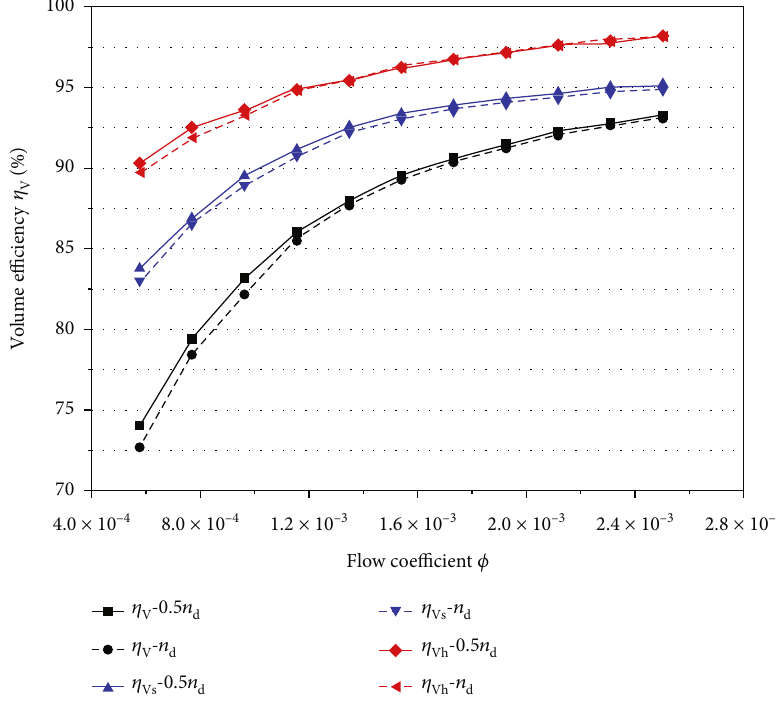
Figure 8: Comparison of the volumetric e ffi ciency under di ff erent rotational